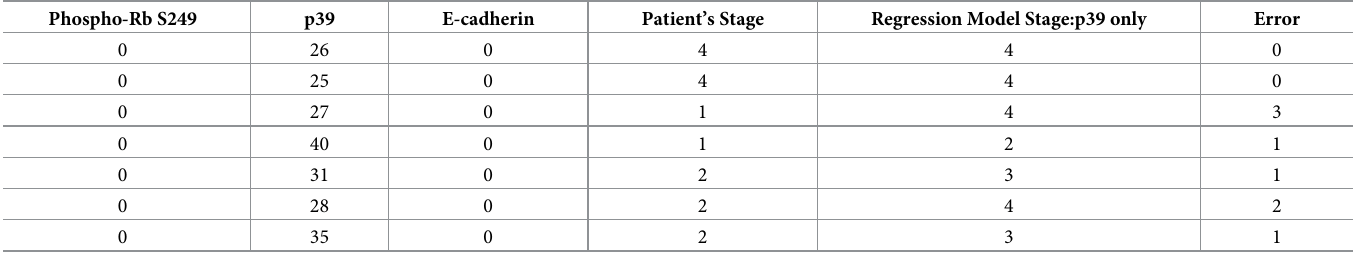
Table 6. A random sample of SCC tumors from our TMAs were selected to calculate tumor staging using our linear regression model when considering only p39 score. The tables show the score for phospho-Rb S249, p39, E-cadherin and the patient´s tumor stage ( first fourth columns , respectively ). The fifth column shows the stage predicted by our linear regression analysis only when considering the p39 score only. The Error (sixth) columns in all five tables show the difference between the vendor score and our linear regression analysis score, a value of 0 indicating identical scores, while a number other than 0 means that the two scores were different by a magnitude equal to the number indicated in the column. p39 alone was only able to accurately predict tumor stage in 2 out of 7 samples.